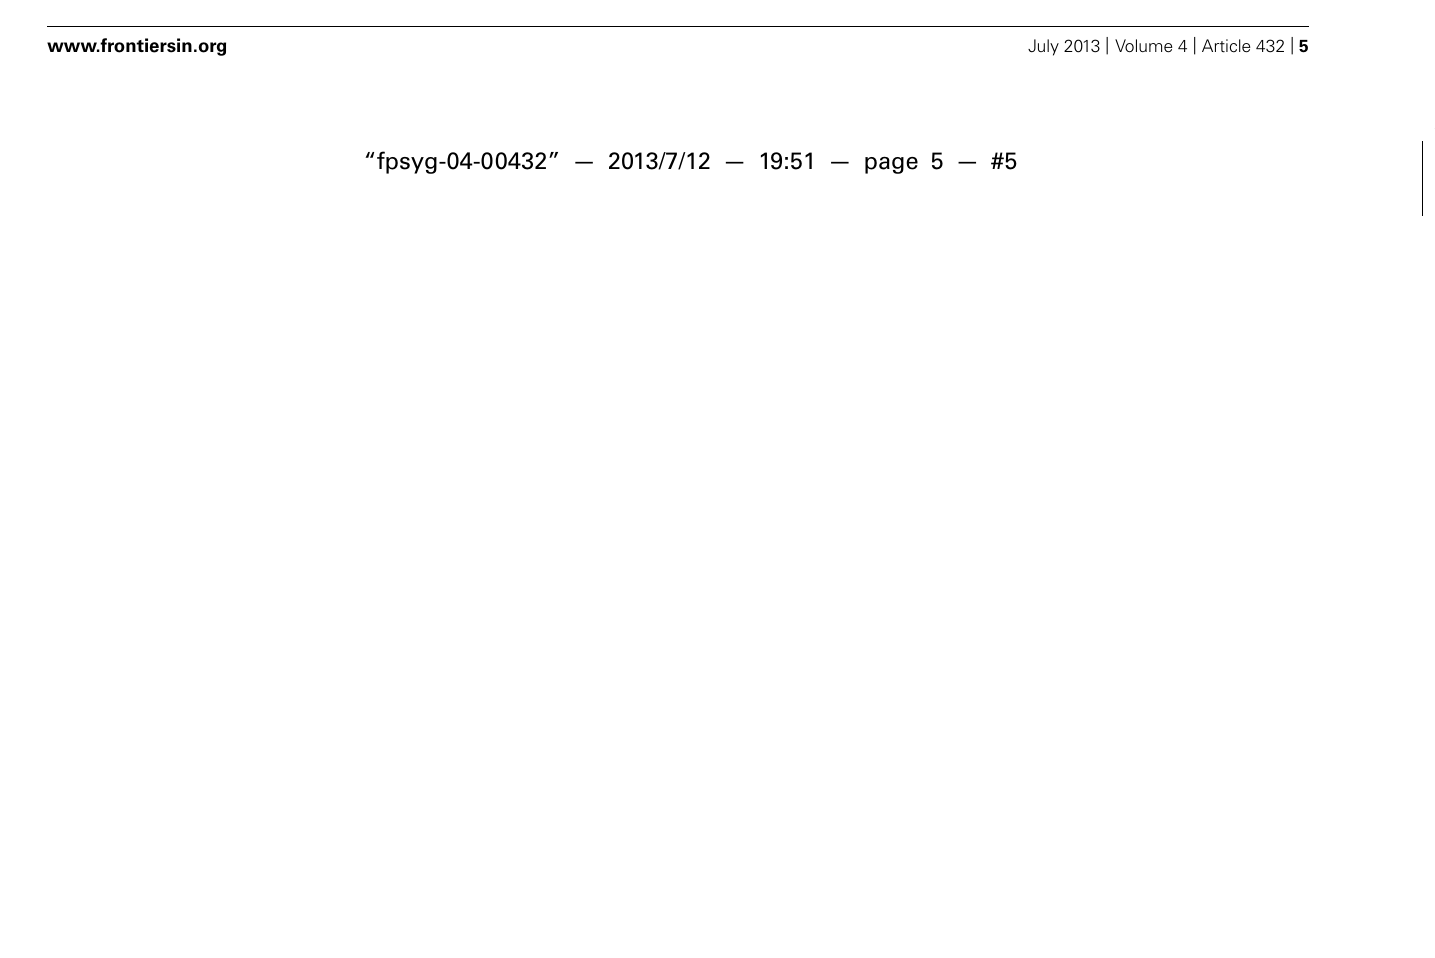
FIGURE 3 | Grand-averaged ERP responses to congruent and incongruentAV stimuli in 6–9 month-old infants with higher and lowerAC-PLS scores at the follow-up age. ERP responses plotted forVbaAba (thin grey),VbaAga (orange),VgaAba (blue), andVgaAga (black) time-locked to the sound onset. Selected channels are shown according to 10–20